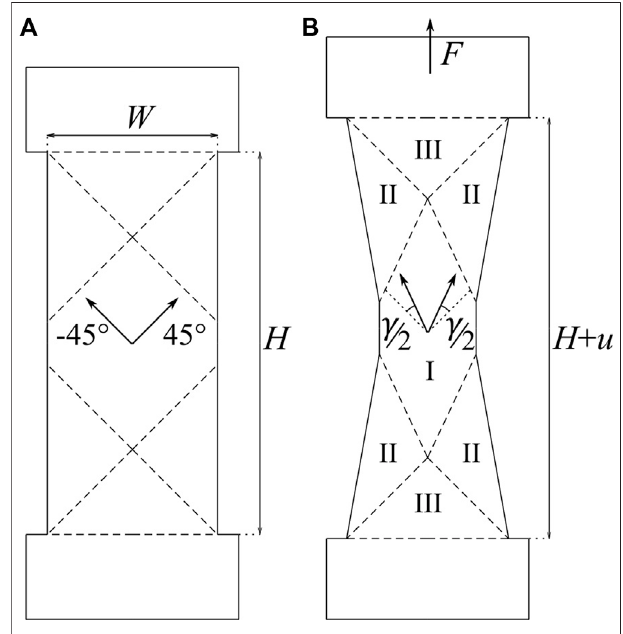
FIGURE 1 | Schematic drawing of the bias extension specimen. (A) Before deformation and (B) theoretical deformation according to a pin-jointed net. The arrows indicate the local fi ber